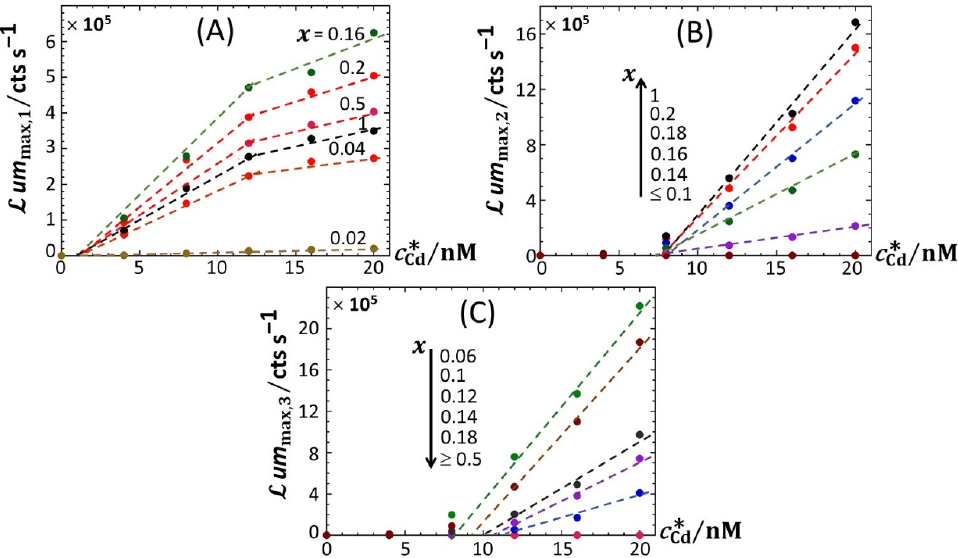
Figure 6. Linear dependence of the maxima of the bioluminescence peaks P1 ( A ), P2 ( B ) and P3 ( C ) on total Cd concentration in solution (indicated) at selected values of x (indicated). (+) symbols: experimental data. Lines: linear regressions. Measurement conditions: nGGM media supplemented with 0.1% tryptone and different concentrations of glucose and xylose (subsumed in the variable x ). Data in this figure originate from those given in Figure 2 (corrected for the corresponding reference measured at 0 nM Cd concentration).